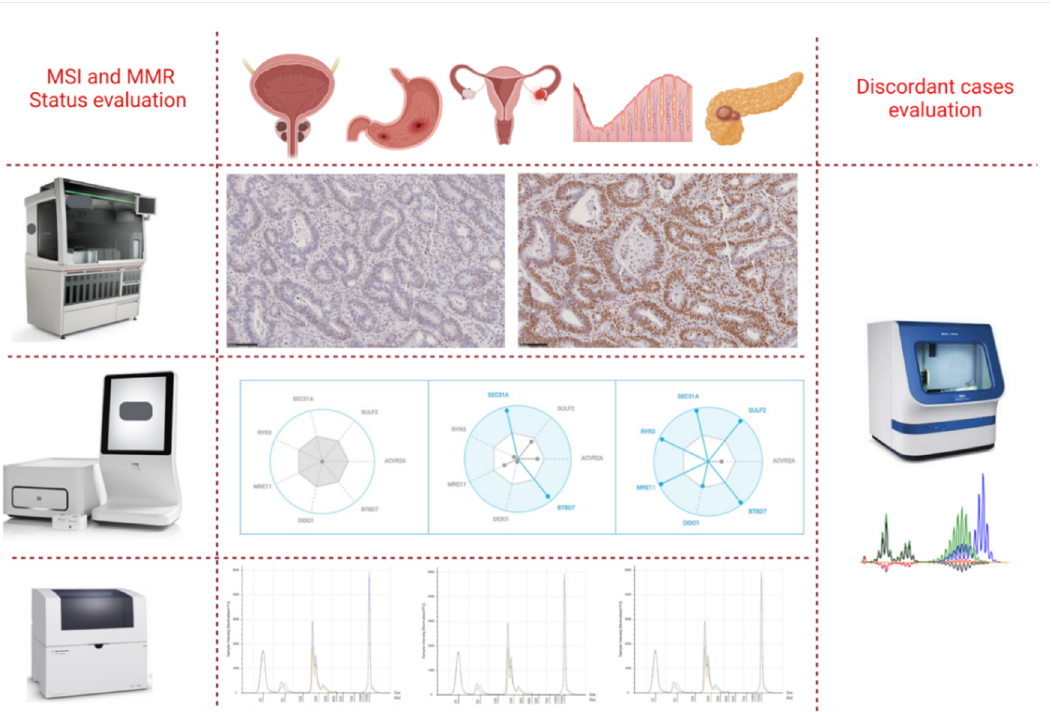
Figure 1. We retrospectively selected a total of n = 185 formalin fixed paraffin embedded ( n = 40 prostate, n = 39 gastric, n = 38 ovarian, n = 35 pancreatic, and n = 33 endometrial) tumor samples, previously analyzed by immunohistochemistry for mismatch repair protein expression. In all samples, microsatellite instability (MSI) status was evaluated by Idylla™ MSI test and TapeStation 4200. Discordant cases were further analyzed by Titano MSI test analysis.